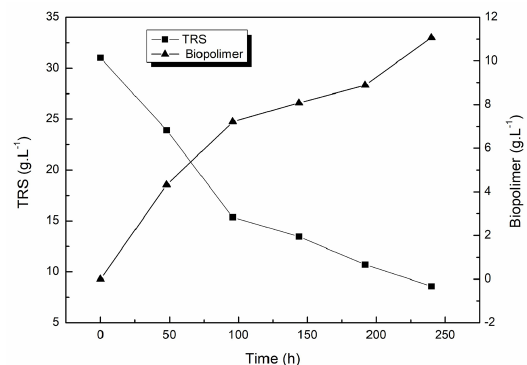
Figure 4. Kinetic curves based at the concentration of total reducing sugars for the culture medium